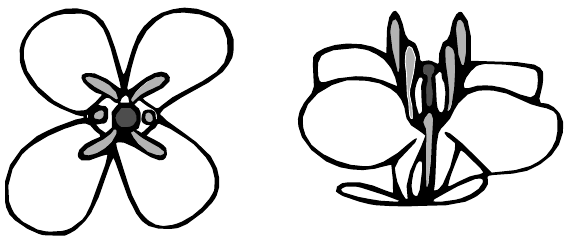
Figure 1. Illustration of a hermaphroditic canola flower in top (left) and profile (right) view. The stigma (dark grey) is surrounded by anthers (light grey), four long and two